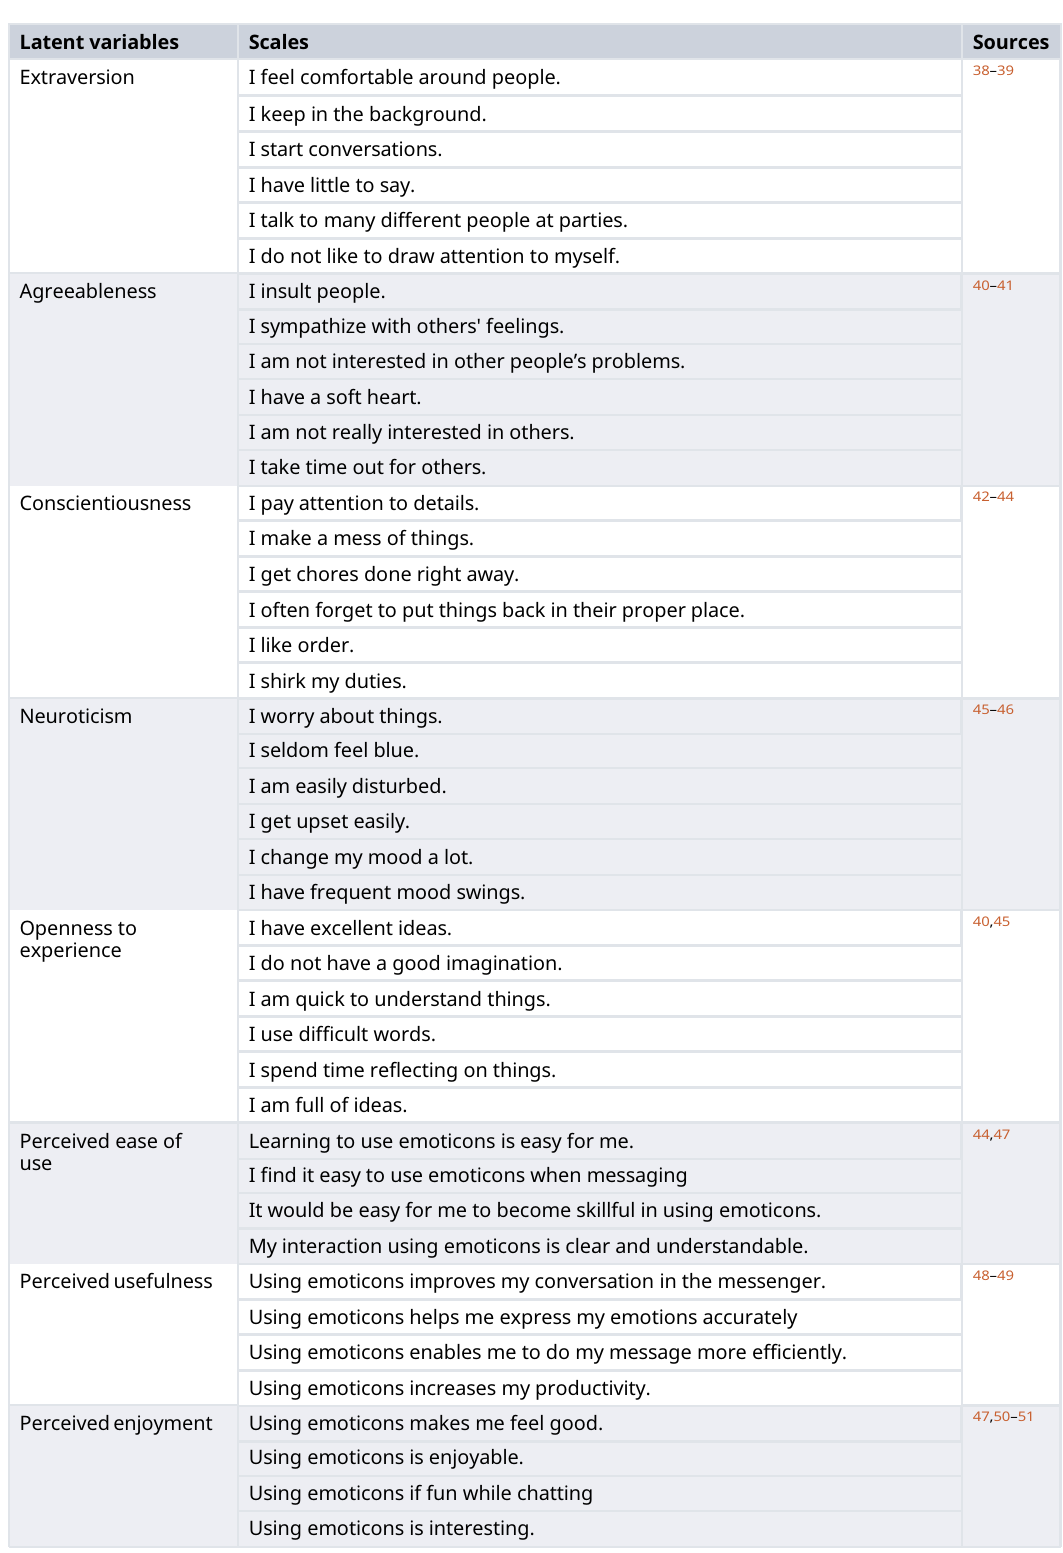
Table 1. Latent variables, scales, and